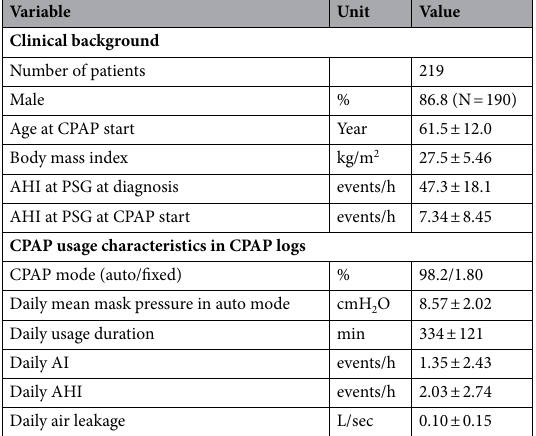
Table 2. Clinical background of 219 participants and their CPAP usage characteristics during CPAP therapy. Data represent mean ± standard deviation. CPAP continuous positive airway pressure; AHI apnea–hypopnea index; PSG polysomnography; AI apnea index.